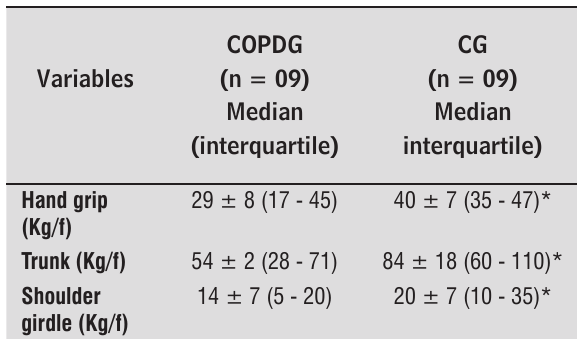
Table 3 - Mean and standard deviation of muscle strength of hand grip, trunk and shoulder girdle of subjects